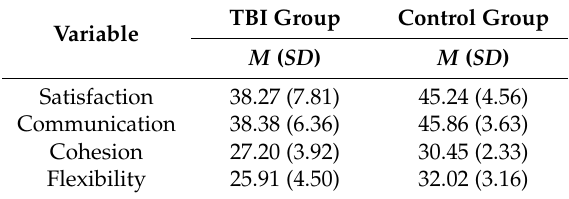
Table 2. Means and Standard Deviations of Family Variables by Group.